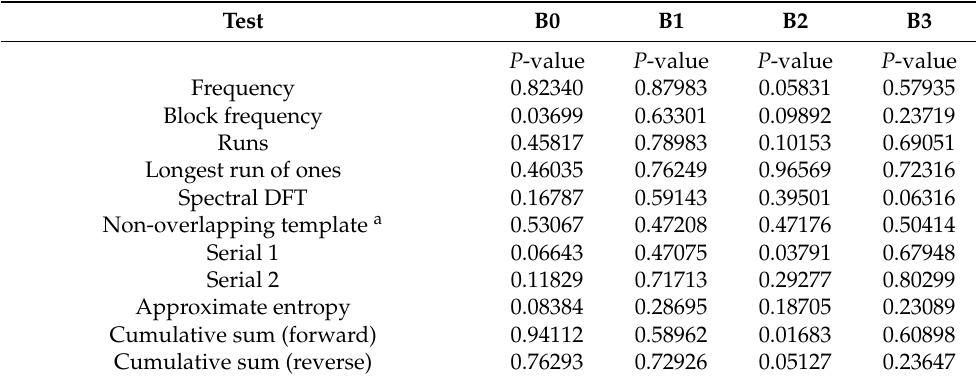
Table 1. NIST SP800-22 test results for bits B0-B3. A specific test was passed when the P -value was larger than the significance level (0.01).